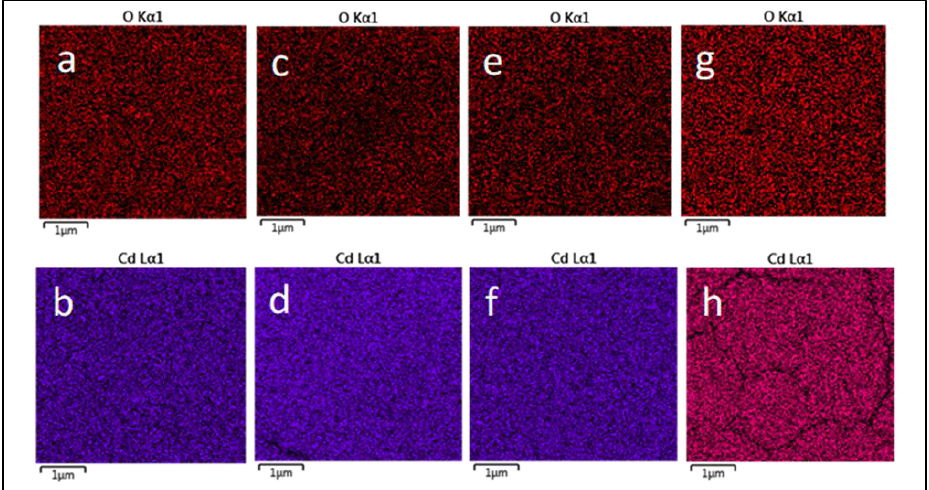
Figure 9. EDX mapping analysis of Cd and O elements with various annealing times: ( a , b ) as-deposited, ( c , d ) 20 min,( e , f ) 40 min, and ( g , h ) 60 min.